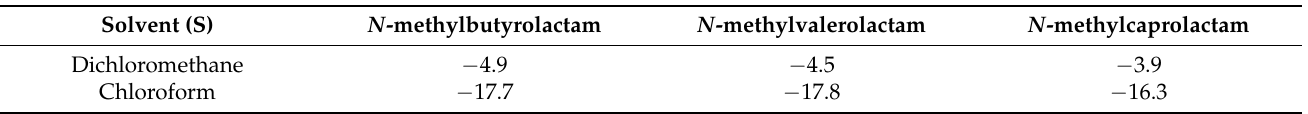
Table 5. Hydrogen bonding enthalpies of N -methylbutyrolactam, N -methylvalerolactam, N -methylcaprolactam in proton donor solvents (S), (kJ · mol − 1 , T = 298.15 K , P = 0.1 MPa) a . Solvent (S) N -methylbutyrolactam N -methylvalerolactam N -methylcaprolactam Dichloromethane − 4.9 − 4.5 − 3.9 Chloroform − 17.7 − 17.8